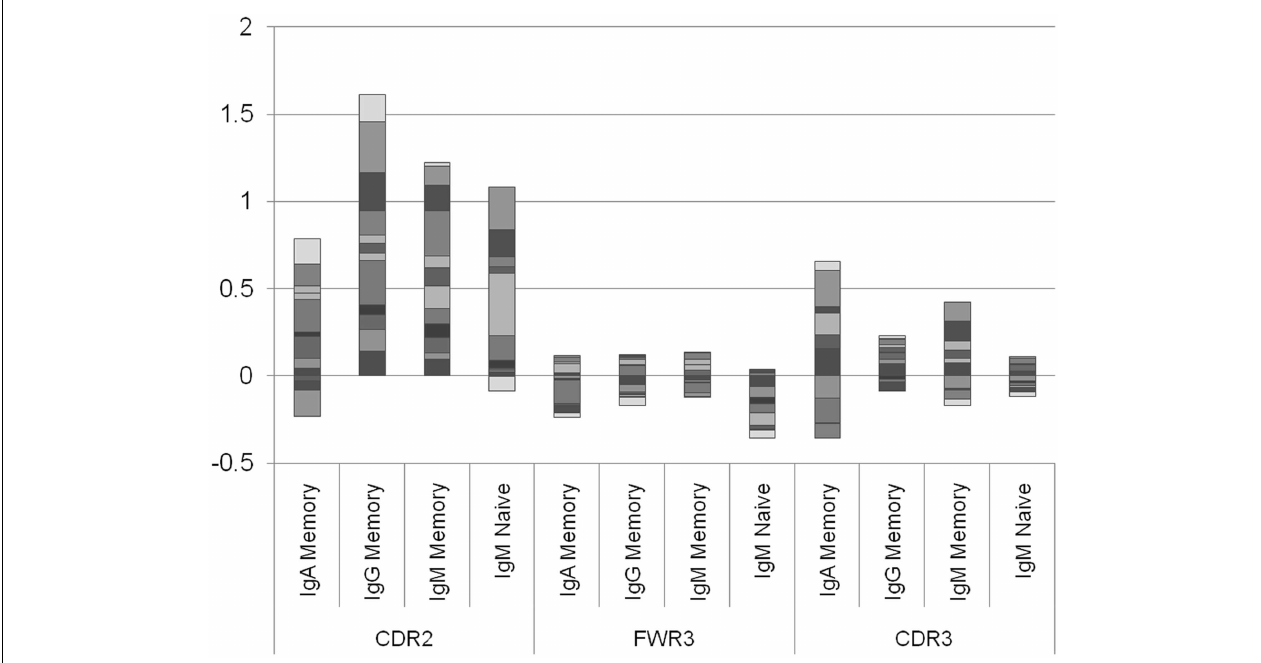
exception of two IgA samples and one naïve IgM sample), in the CDR3 there are approximately the same number of donors with negative selection and with positive selection.This shows that the selection in CDR2 is a universal feature, while in CDR3 it may depend on the random junction initially produced or in the different exposures to